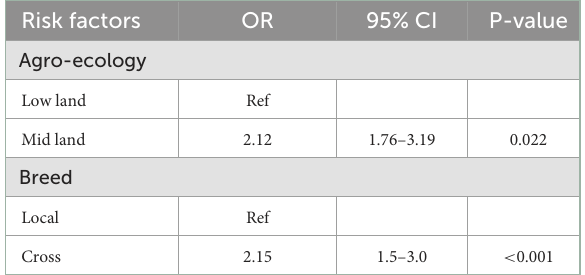
TABLE 4 Multivariable logistic regression for individual level risk